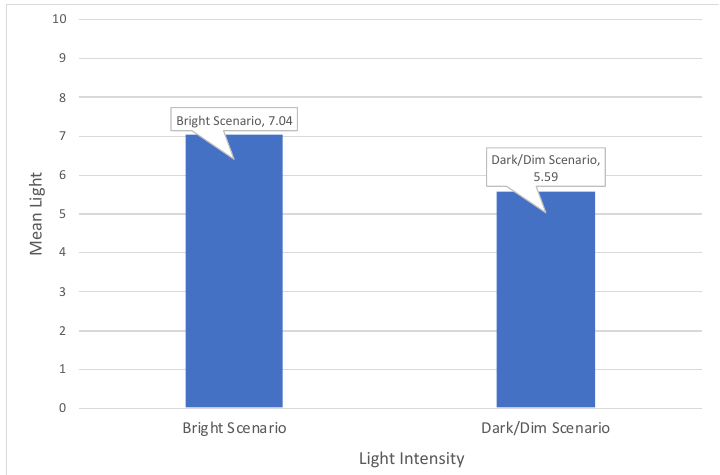
Figure 8. Light intensity manipulation check: comparison of means .